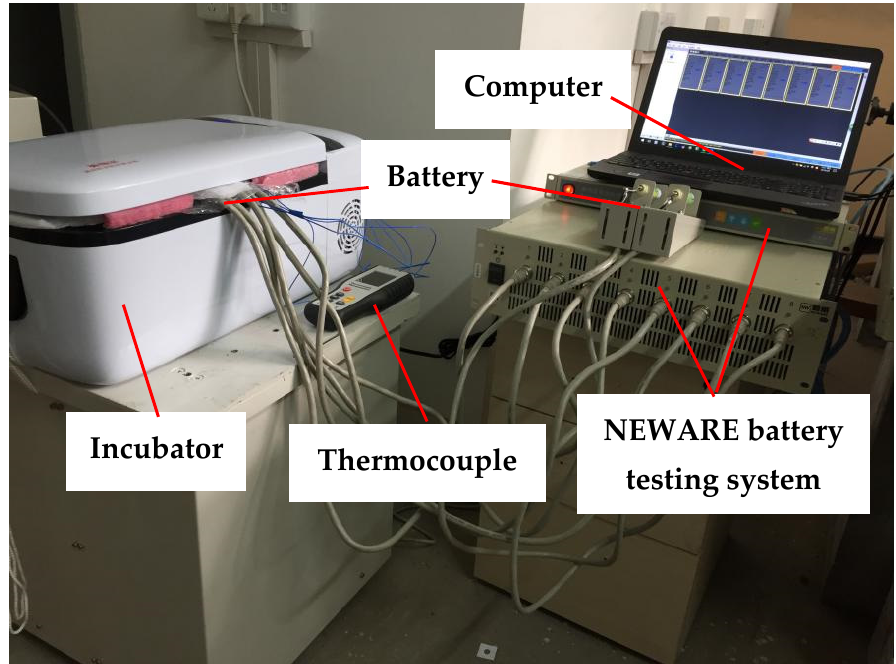
Figure 4. The experimental devices for battery test. As shown in Figures 3 and 5, the curves of experimental and simulation results are basically consistent. The average voltage error between simulation and measurement was less than 0.1 V. The average temperature error between simulation and measurement was within 5%. There were some differences between the experimental and the simulation data. The main reason is that the experimental process is affected by the environment and measuring instruments, and the error was caused by the inaccurate measurement